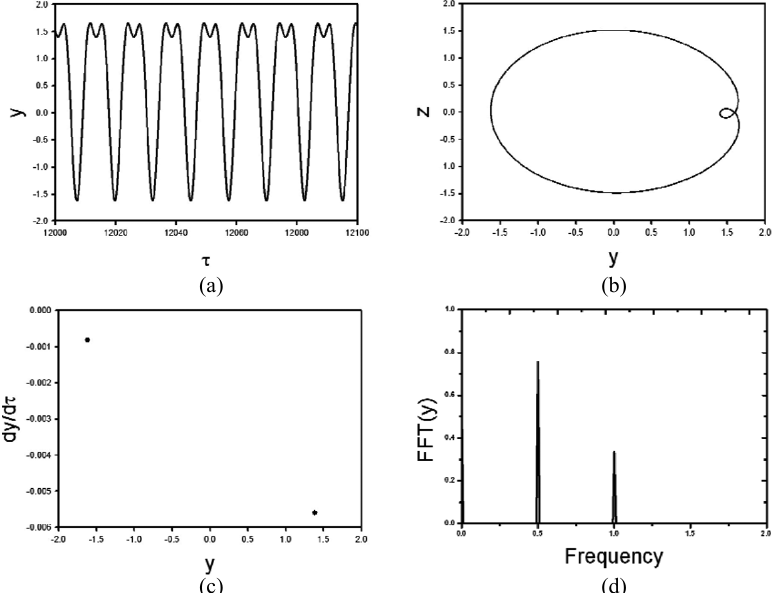
Fig. 17. Dynamic characteristic of the y-displacement of the mid-span point with γ m = 4000 T 2 m/H. (a) Time history; (b) Orbital trajectory; (c) Poincar´e section; (d) FFT.